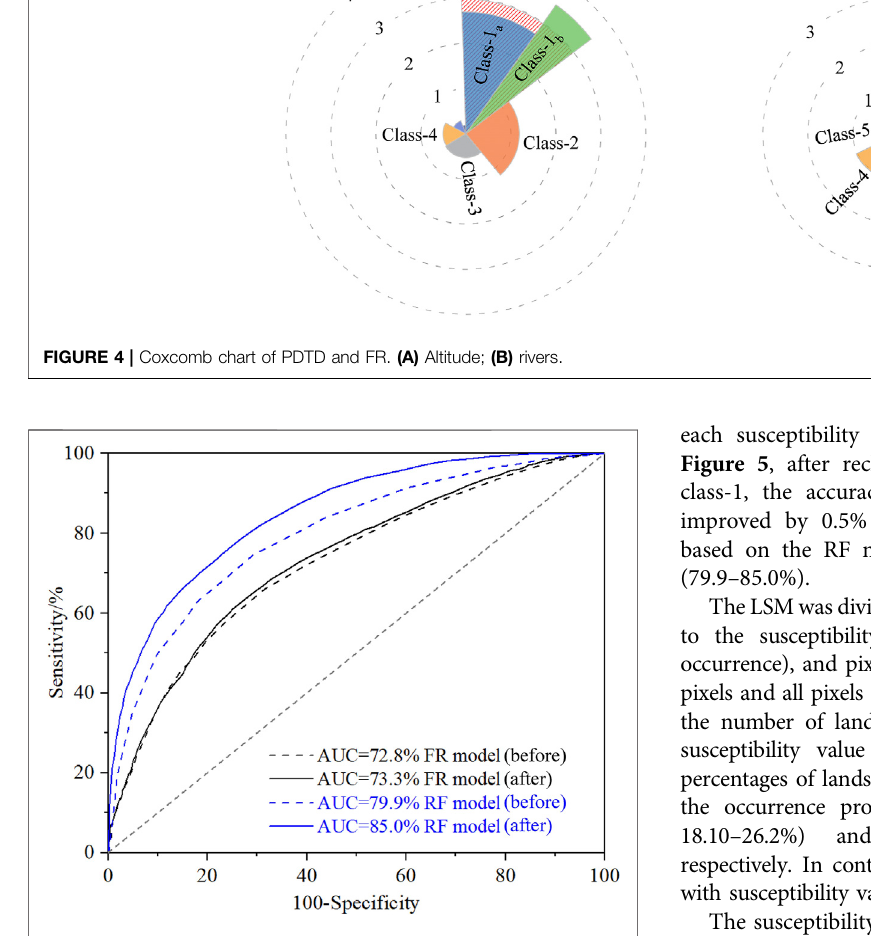
FIGURE 5 | Accuracy analysis of susceptibility